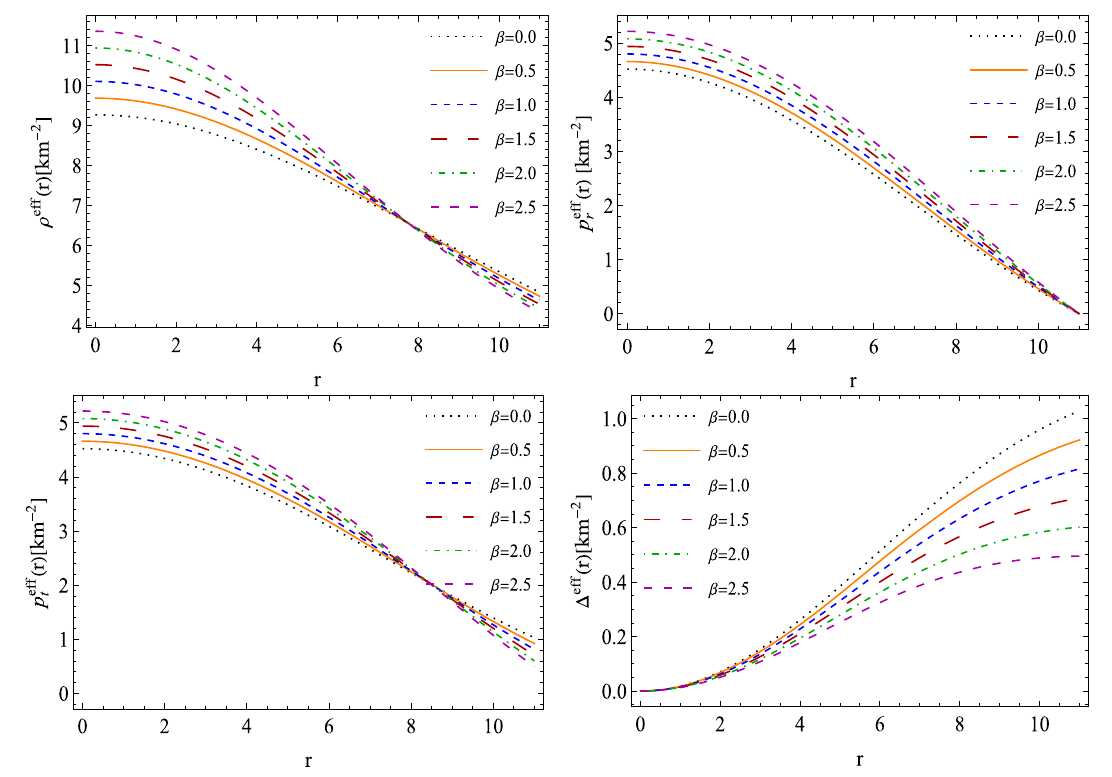
figures. We use the following numerical values, A = 0 . 0078 km − 2 and B = 0 . 0093 km − 2 , α = 1 . 2 km − 2 , and β = 10 − 46 , to plot above figures for solution